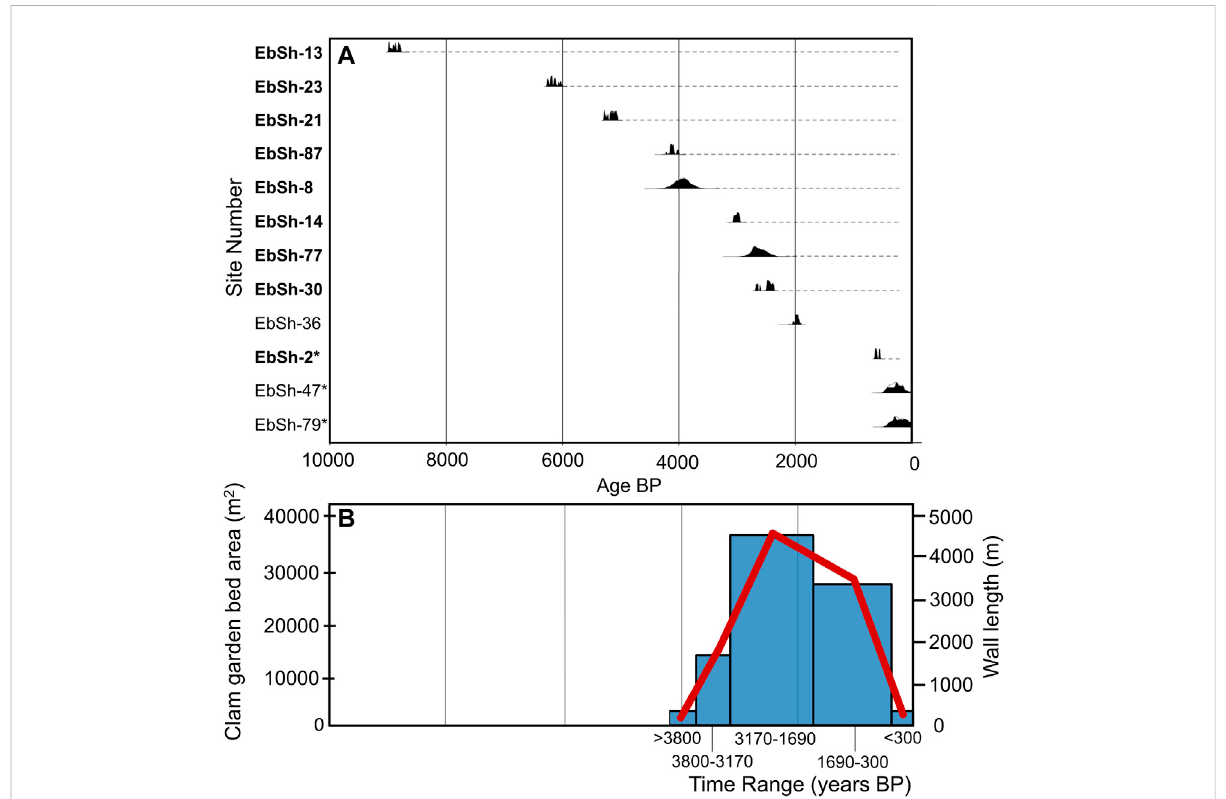
FIGURE 10 (A) CalibratedradiocarbondaterangesfrombasaldepositsinsettlementsinKanishandWaiattBays.Boldedsitenumbersarethoseforwhichwe also have radiocarbon determinations from upper deposits. Based on these radiocarbon dates and stratigraphic pro fi les, we infer that these sites were occupied more or less continuously into the protohistoric period (dashed lines). We have no upper radiocarbon dates with which to evaluate the other sites, but assume they had similar settlement histories. Small sites are indicated with an asterisk. Dates were calibrated and plotted usingOxCal4.4(BronkRamsey2009,2017). (B) Thetotallengthofterracewalls(redline)andgardenarea(bluebars)bytidalheightinKanishBayper time range, showing the relatively greater effort put into cultivating clams in clam gardens 3,170 – 1,690 cal BP, and the dramatic decline in recent years. Thedatadepictedaresummedwalllengthsbasedonpreviouslycollectedspatial data(Lepofskyetal.,2020),ratherthansummed samplewall